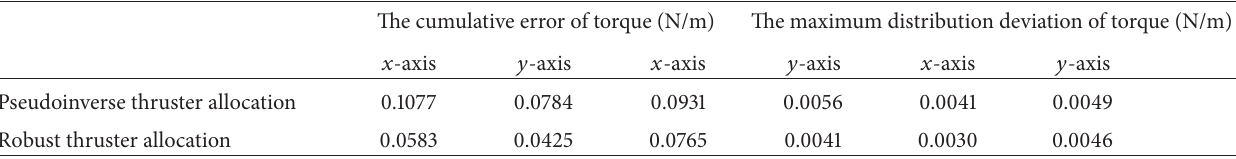
Table 3: The simulation result when the control efficiency matrix is with the uncertainty of 5%. The cumulative error of torque (N/m) The maximum distribution deviation of torque